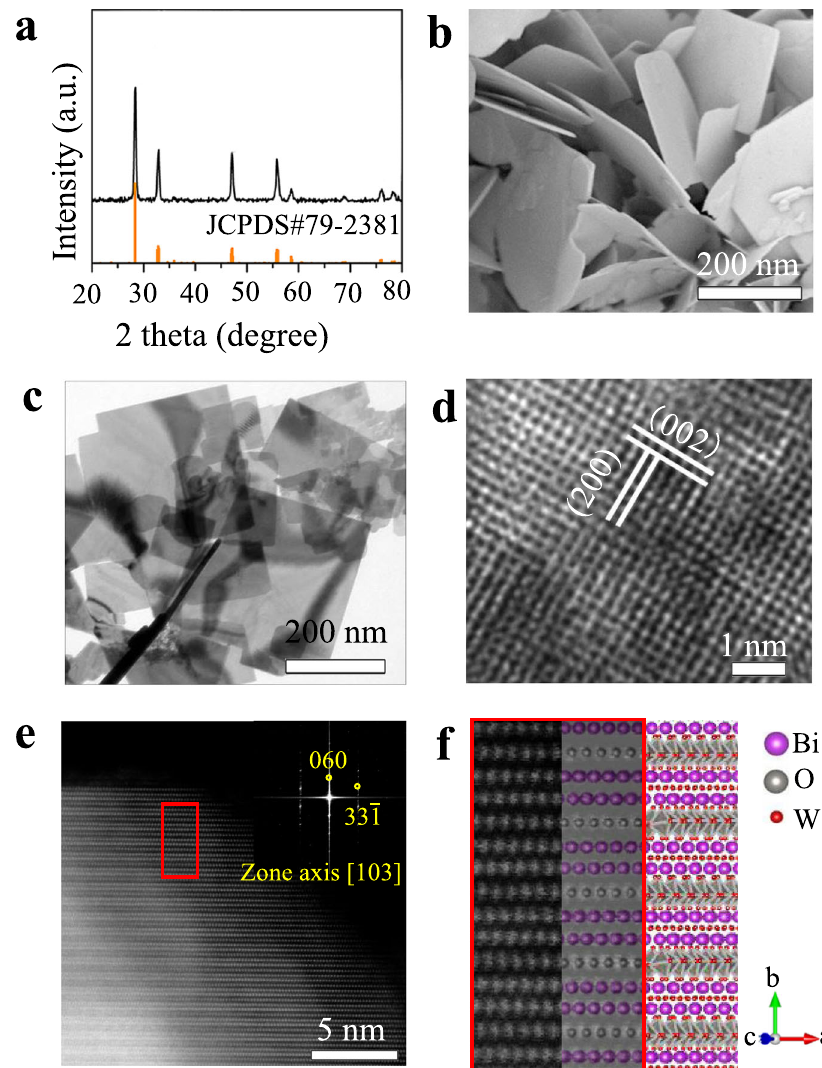
Fig. 1 Structures of Bi 2 WO 6 sample. a XRD pattern, b SEM photograph, c TEM photograph, d HRTEM image, and e Aberration-Corrected HAADF-STEM image. The inset image in e denotes the FFT of STEM. f Comparison between the STEM image and the structure model of the layered structure of Bi 2 WO 6